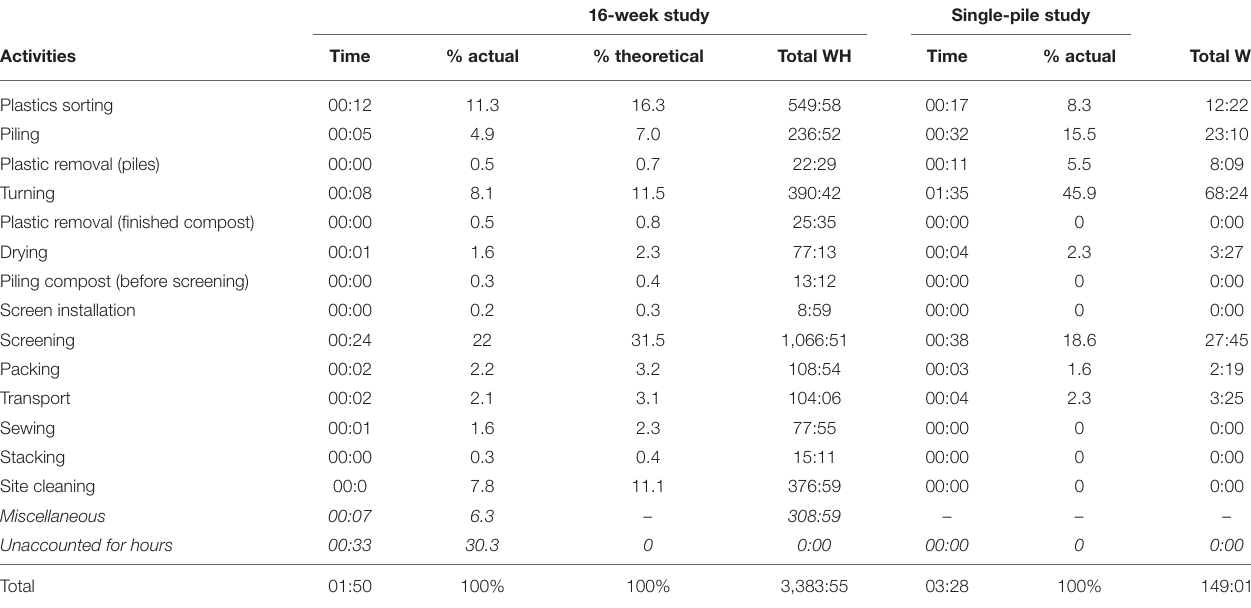
TABLE 1 | Time (h:m), work-hours (WH) and percentages in producing 1 bag of compost (time = time per bag). 16-week study Single-pile